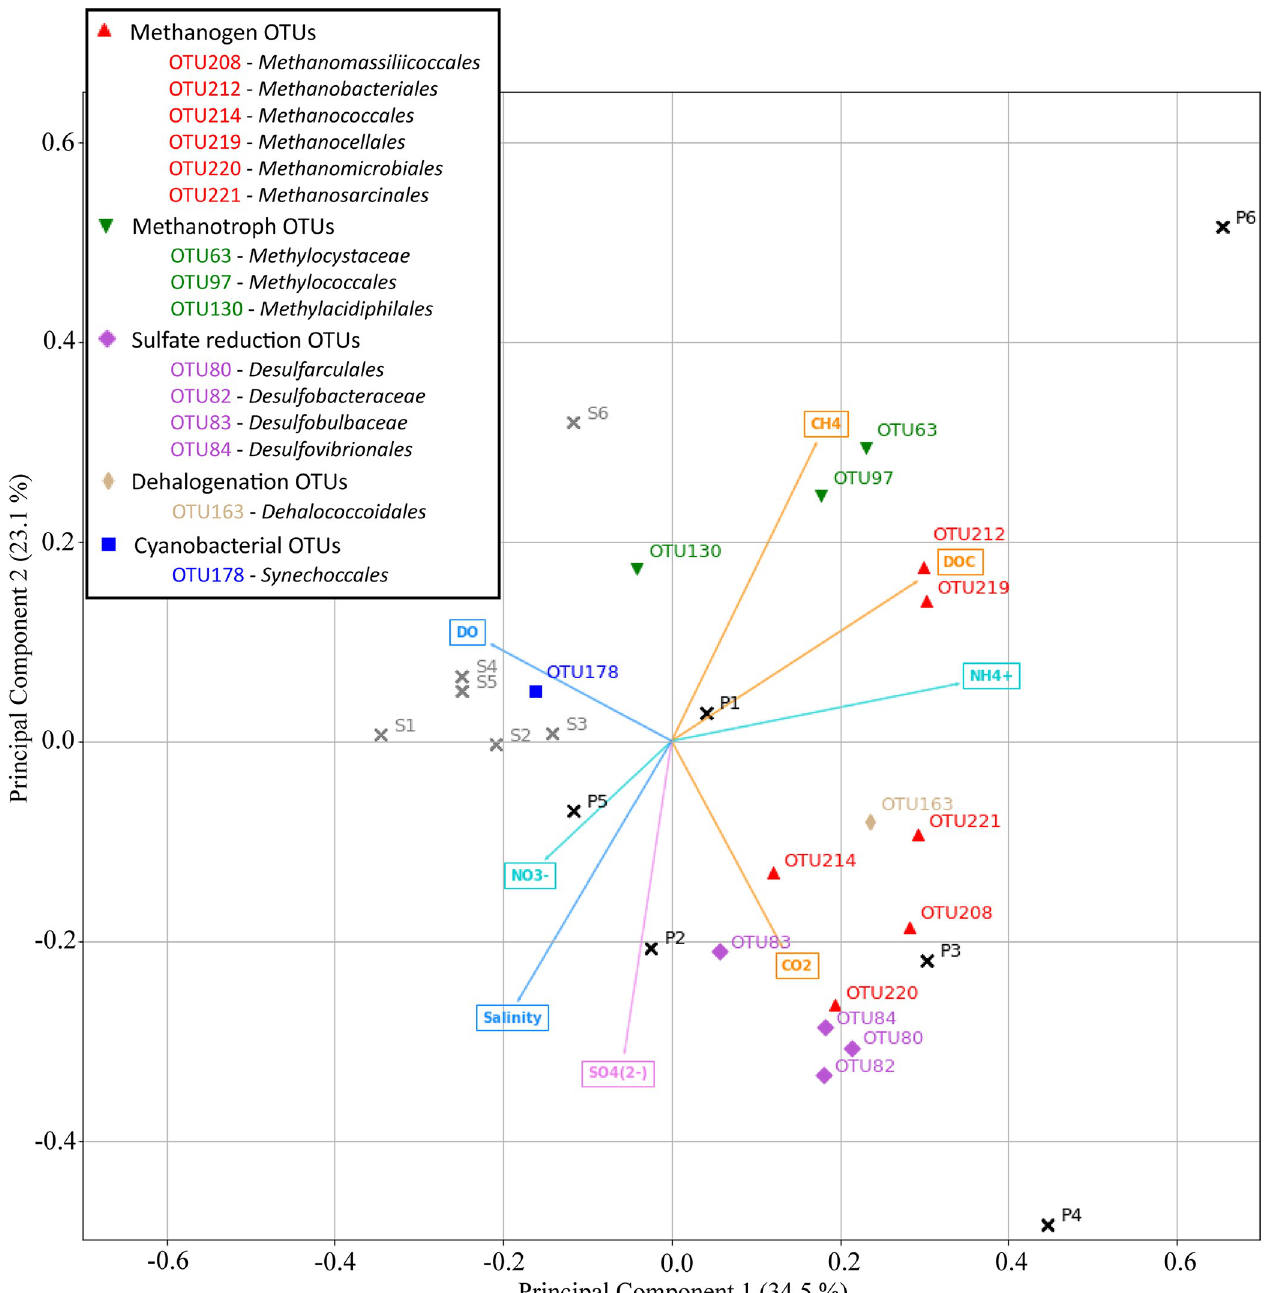
Fig 7. PCA biplot depicting variations in environmental parameters (nutrient, greenhouse gas and physicochemical). OTUs included in the scatter plot are specified on the upper left. Surface water samples for Sites 1–6 are shown as grey crosses with the suffix ‘S’ and pore water samples are depicted as black crosses with the suffix